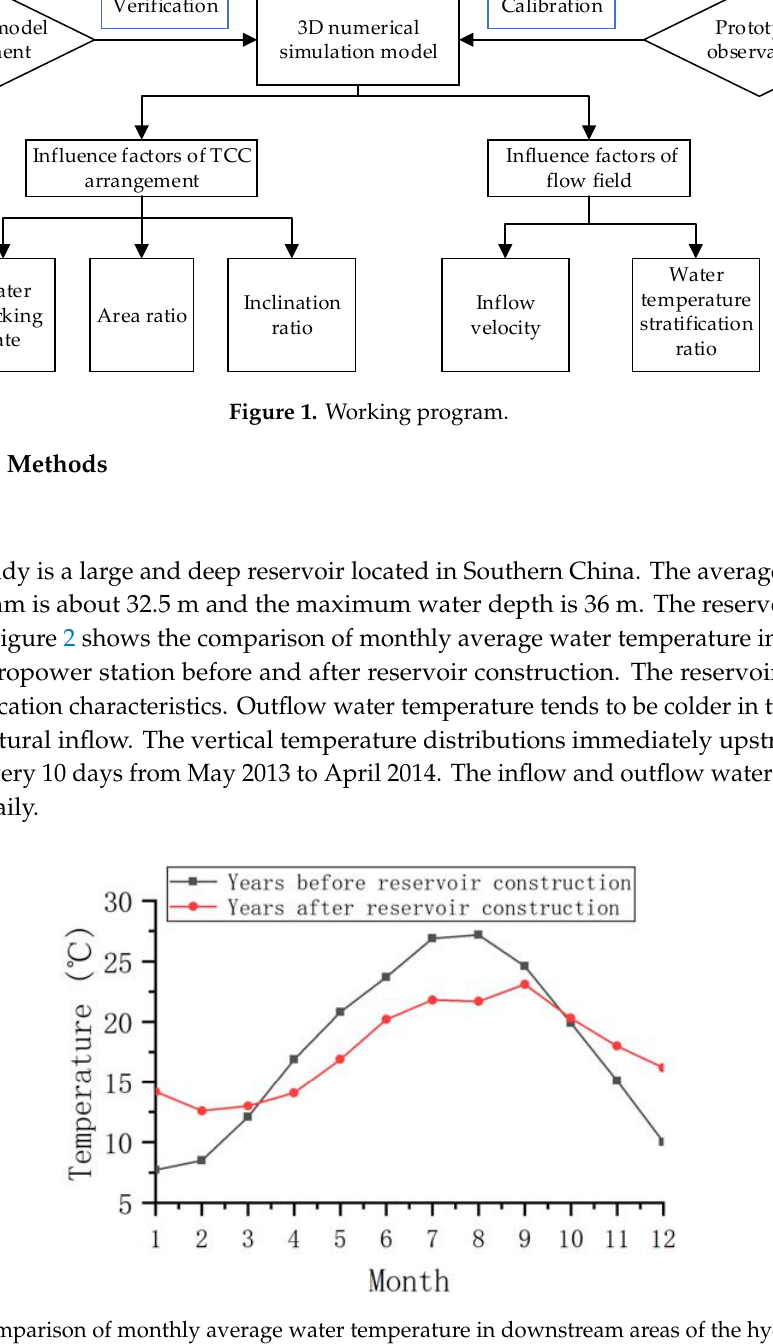
Figure 2. Comparison of monthly average water temperature in downstream areas of the hydropower station before and after reservoir construction.